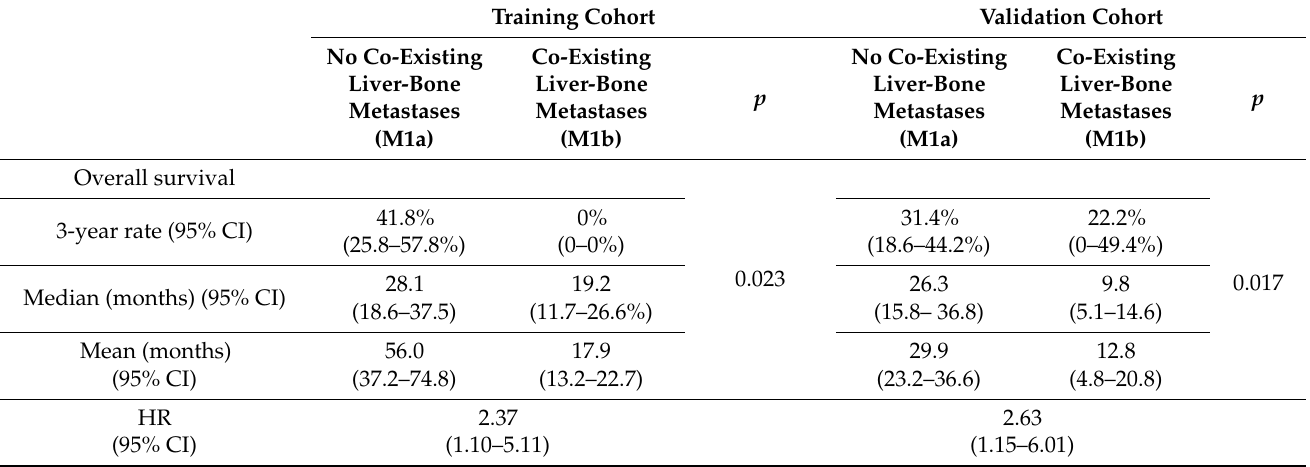
Table 3. Overall survival of M1 segregation by the co-existence of liver and bone metastases in Set 1 RPA (Anatomic-RPA groups) in the training and validation